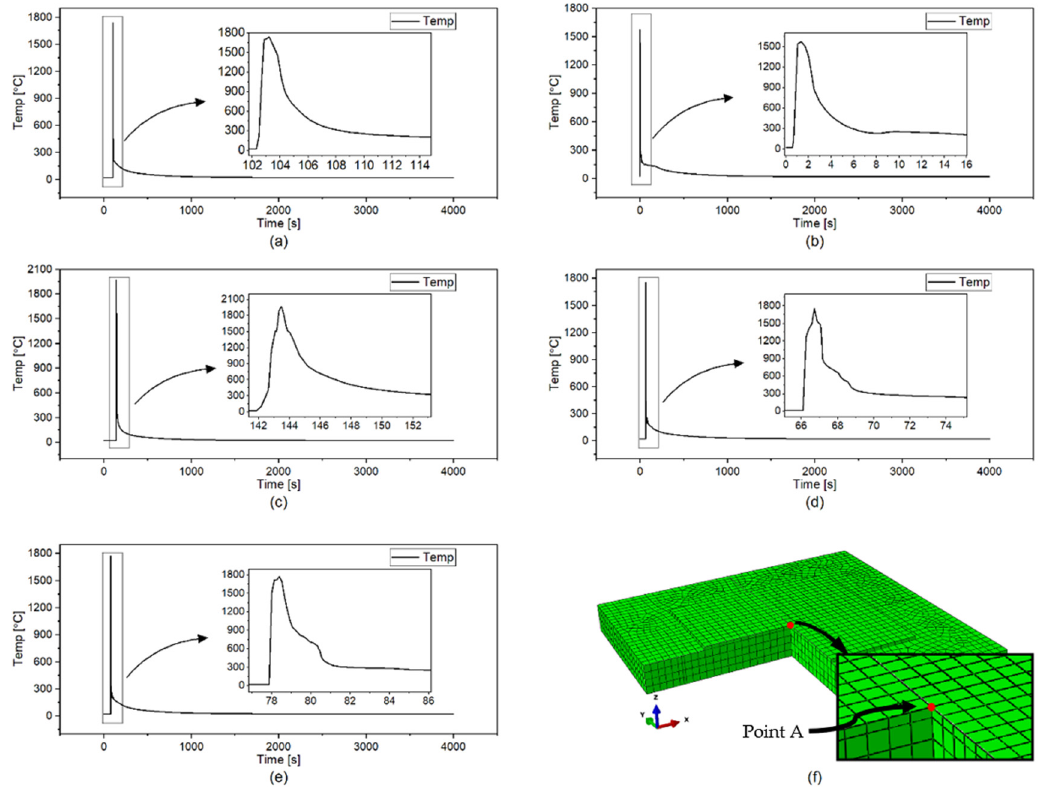
Figure 7. Temperature history at the Point A. ( a ) alternate, ( b ) in–out, ( c ) out–in, ( d ) raster, ( e ) zigzag, ( f ) The location of the Point A.